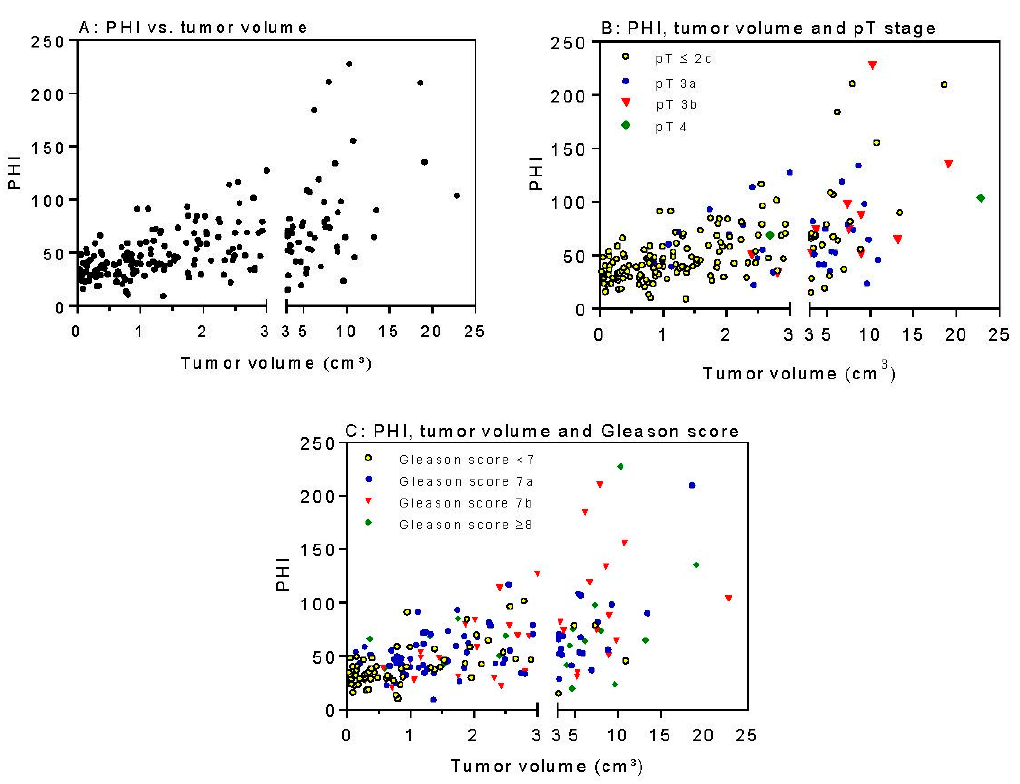
Figure 1. PHI values in relation to tumor volume, pT stage and Gleason score as indicated in ( A – C ). Table 5. Calculated areas under the receiver operating characteristic (ROC) curves of the serum parameters (left column) to predict tumors with particular characteristics (top row). The 95% confidence intervals of the area under the curves (AUCs) are given in